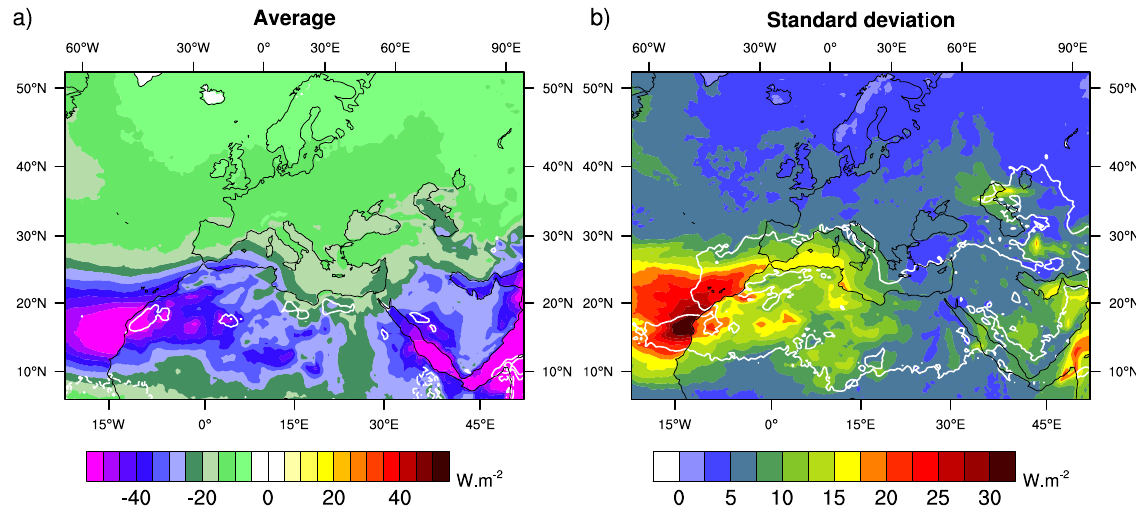
Figure 8. Aerosol SW direct radiative forcing (DRF): (a) Average in summer 2012 for PROG (colours) and the PROG-PROG-M difference Fig. 8. Aerosol SW direct radiative forcing (DRF): a) Average in summer 2012 for PROG (colors) and the PROG-PROG-M difference (white lines, interval is 5Wm − 2 ). (b) Standard deviation of daily DRF for PROG (colours). The white line indicated the region where the (white lines, interval is 5 Wm − 2 ). b) Standard deviation of daily DRF for PROG (colors). The white line indicated the region where the ratio ratio between the standard deviations of PROG and PROG-M is higher than between the standard deviations of PROG and PROG-M is higher than 2.